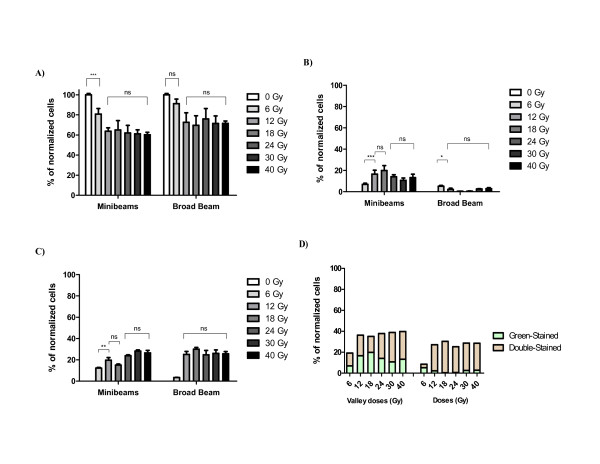
(A-D) - Flow cytometry results. Normalized histograms obtained by flow cytometry 48 hours after irradiation at several doses, with MBRT (left) and BB (right). The plots correspond to: (A) the unstained surviving cells, (B) the positive green fluorescence cells, corresponding to those cells undergoing apoptosis in an early stage, (C) double stained cells, with propidium iodide and annexin, indicating as late apoptotic as necrotic dead cells, and (D) the early (in green) and late (in green and red) apoptotic cells, in order to represent altogether the different death processes.